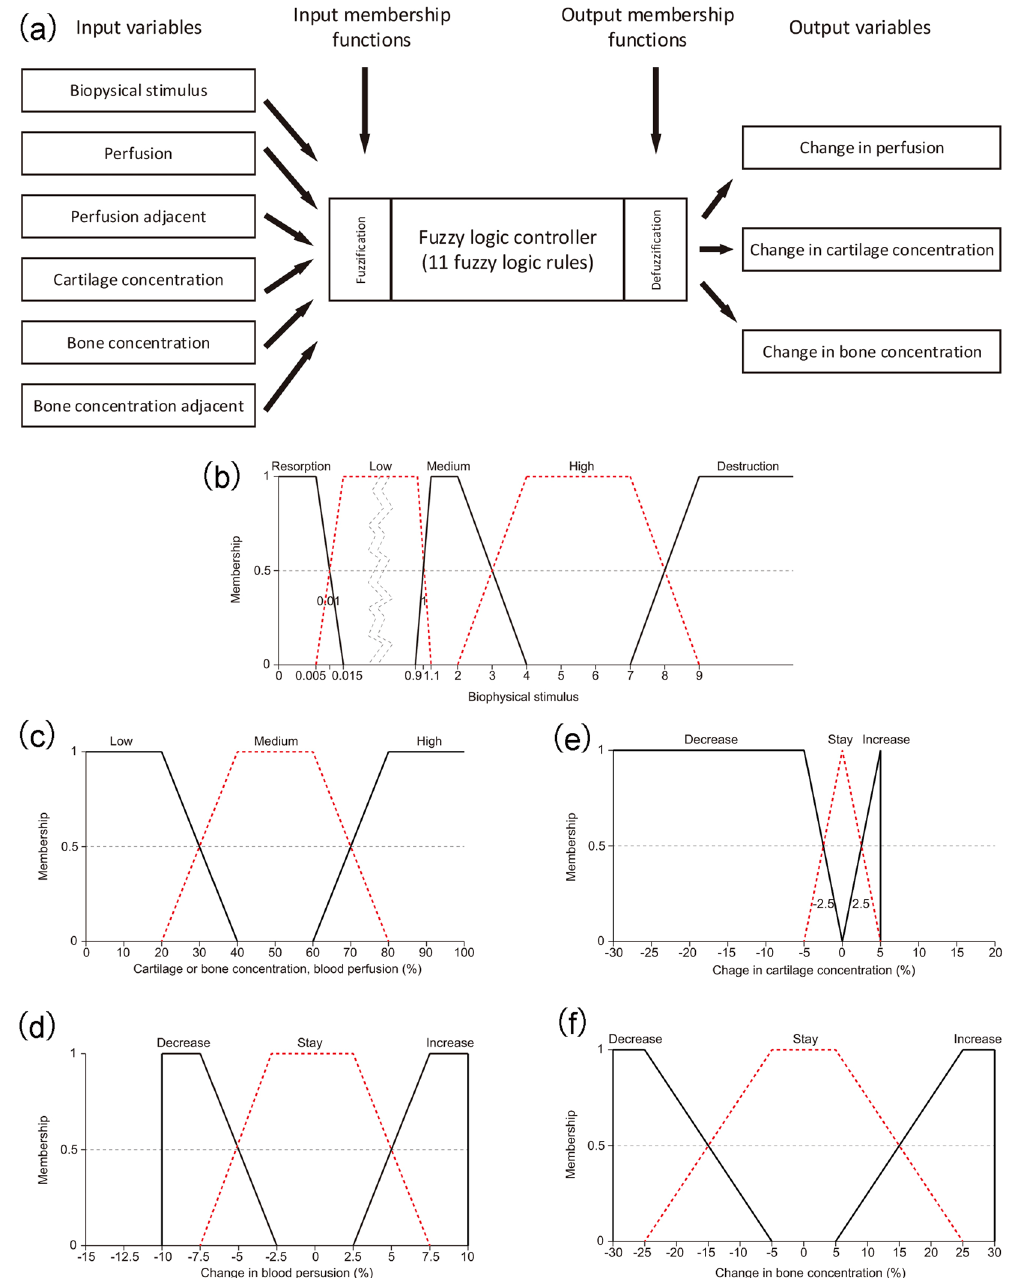
Figure 8. ( a ) Fuzzy logic controller of tissue differentiation within the callus region. The controller has six input variables and three output variables. The fuzzification module transforms numerical values to associated linguistic values and the defuzzigication module transforms linguistic values to associated numerical values. ( b ) Membership function of biophysical stimulus. ( c ) Membership functions of perfusion, perfusion in an adjacent element, cartilage concentration, bone concentration and bone concentration in an adjacent element. ( d ) Membership function of change in perfusion. ( e ) Membership function of change in cartilage concentration. ( f ) Membership function of change in bone concentration. Among these membership functions, ( b ) and ( c ) represent the membership function of input variables. ( d ), ( e ) and ( f ) represent the membership function of output